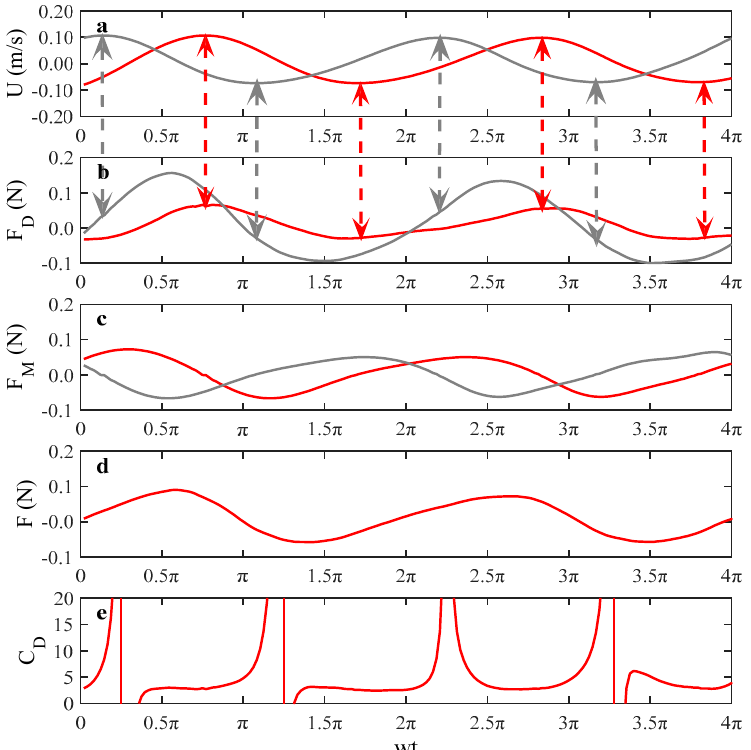
Figure 6. ( a – d ) Time-varying U , F D , F M , and F data over two wave periods. The gray lines are before realignment, and the red ones are after realignment. The vertical double-arrowed lines in panel (a) and ( b ) indicate the synchronization status before and after the realignment; ( e ) Time-varying C D derived based on realigned U and F D data. The shown test case is wave0712 with 7 cm wave height and 1.2 s wave period.